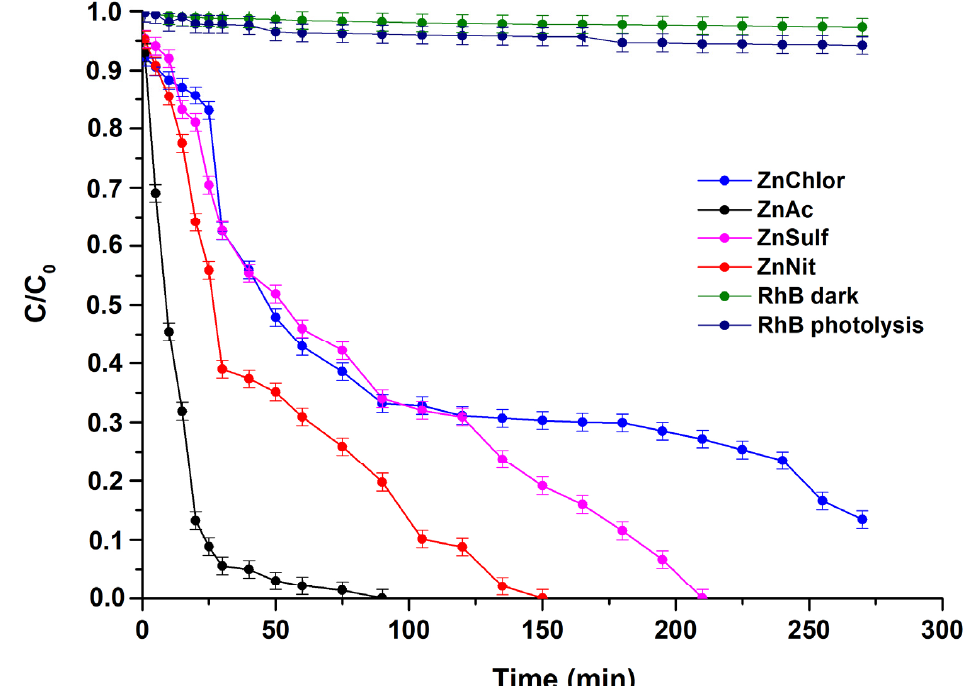
Figure 12. Degradation of Rhodamine B under UV irradiation, by the four different ZnO powders, produced by different precursors.